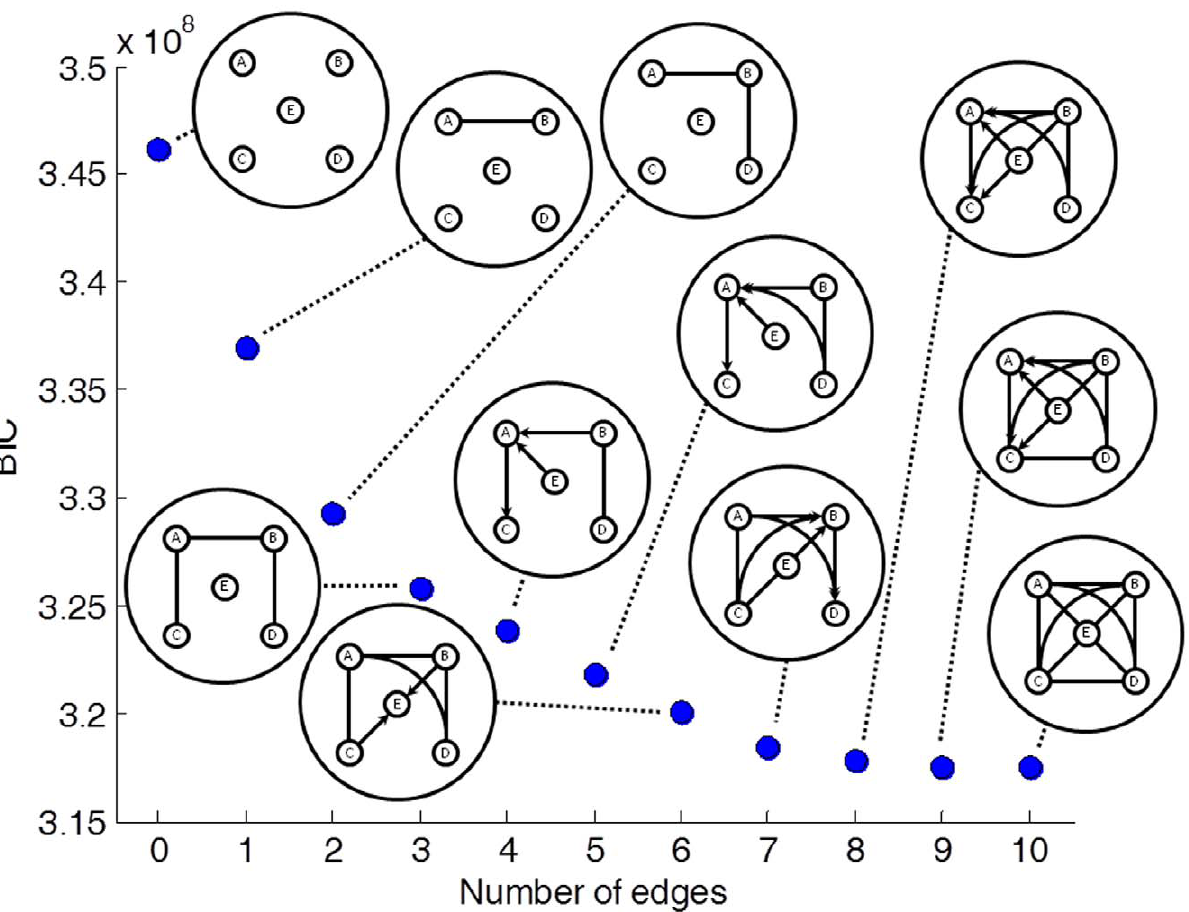
Figure 2. BIC scores (dots) and pDAGs of human models M 1 through M 10 . The BIC scores of the models M 1 , M 2 , ... , M 10 are shown as dots, and the pDAGs of the models themselves are plotted next to each dot. These models represent relationship between sites rather than true causality, as indicated by the fact that some edges reverse their direction in different models. The number of parameters required to describe each of the models is 5 ( M 0 ), 6 ( M 1 ), 7 ( M 2 ), 8 ( M 3 ), 10 ( M 4 ), 14 ( M 5 ), 13 ( M 6 ), 17 ( M 7 ), 21 ( M 8 ), 29 ( M 9 ), and 31 ( M 10 ).